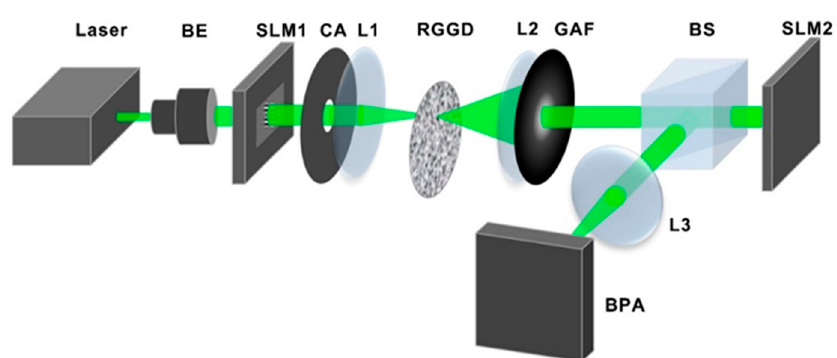
Figure 9. A scheme of optical layout for generating and measuring HGCSMLG 0 l . Laser, 532 nm; BE, beam expander; SLM1, SLM2, spatial light modulator; CA, circular aperture; L1, L2, L3, lenses; RGGD, rotating ground glass disk; GAF, Gaussian amplitude filter; BS, beam splitter; BPA, beam profile analyzer.